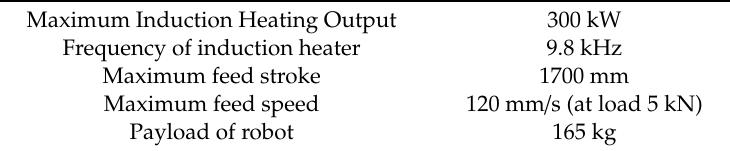
Table 1. Main specifications of experimental three-dimensional hot bending and direct quench (3DQ) machine.